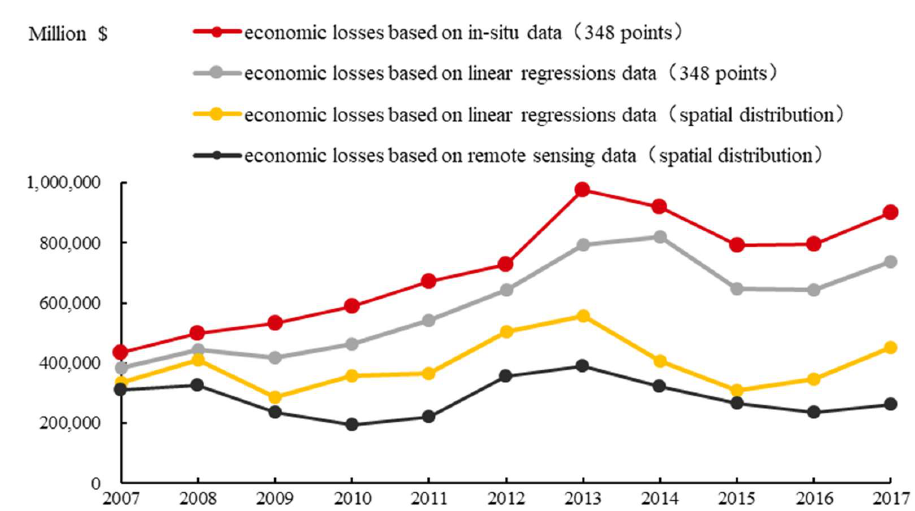
Figure 7. Comparison of economic losses based on in-situ data, remote sensing data and linear regressions data (348 points and spatial distribution).